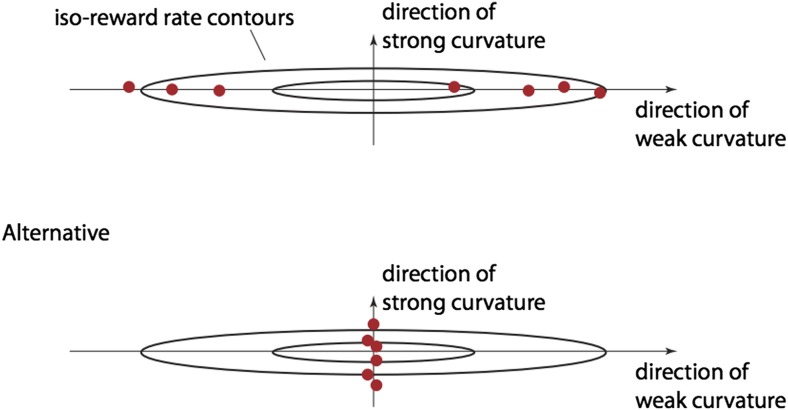
DOI:
http://dx.doi.org/10.7554/eLife.06678.008